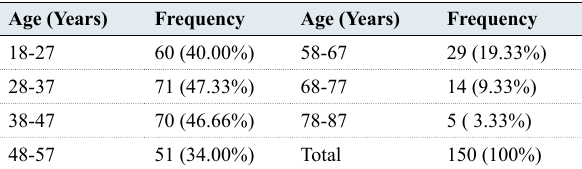
Table 1: Studied population showing distribution pattern of